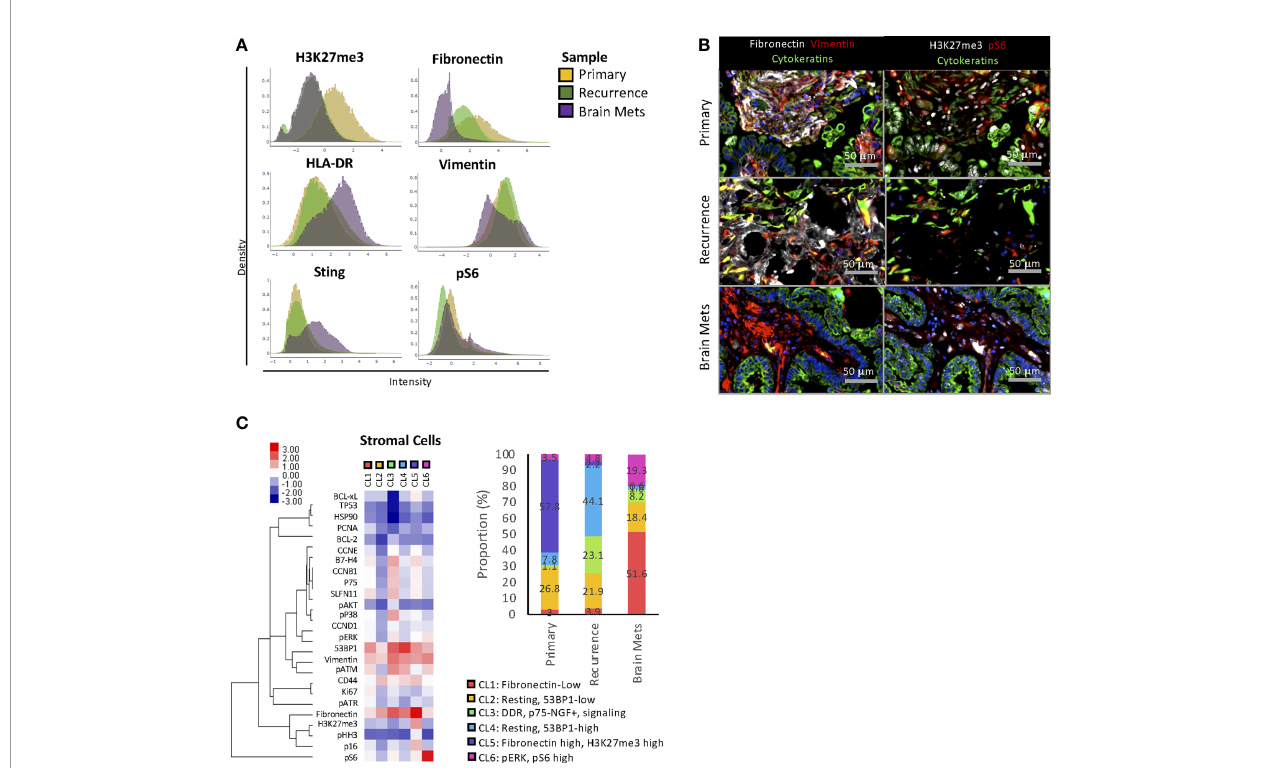
FIGURE 3 | Stromal cell phenotype. (A) Density plot showing the distribution of expression of speci fi c markers across stromal cells from each sample. (B) Representative immunostaining of markers that are differentially expressed across samples. (C) A K-Mean clustering was performed on stromal cells. The heat maps represent the median expression of each marker within each cluster (CL), and the phenotype of each cluster is annotated. The histogram represents the frequency of each cluster within the samples, and the cluster phenotypes are described below the histogram. The full name of each protein can be found in Supplementary Table S1